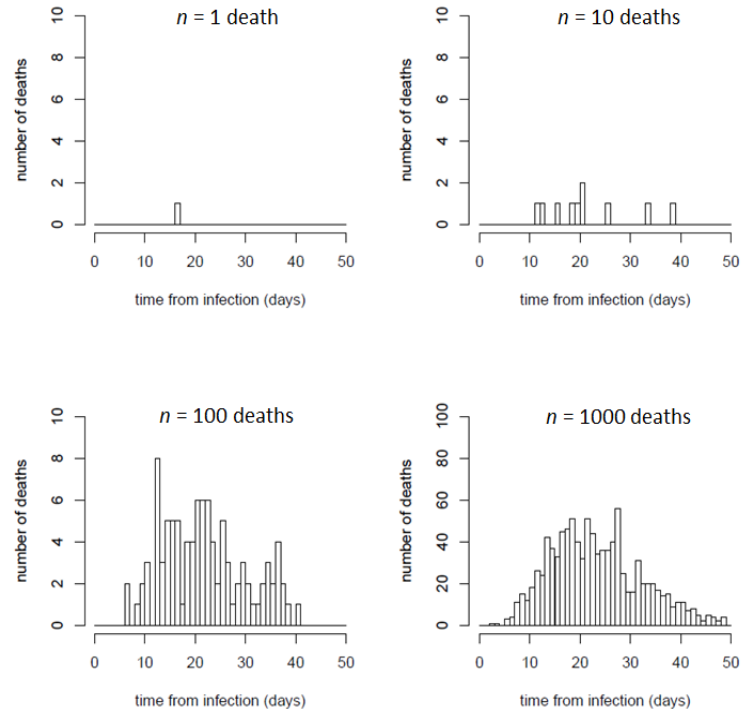
Figure 2. Examples of random discrete distributions of samples of n = 1, 10, 100, 1000 expected deaths, according to the infection-to-death (ITD) probability distribution used in this work. For samples of a small size, the distribution can be very different from the probability curve shown in Figure 1b, while for samples of a larger size (e.g., 100 or 1000 deaths), the discrete distributions get closer to the probability distribution curve.